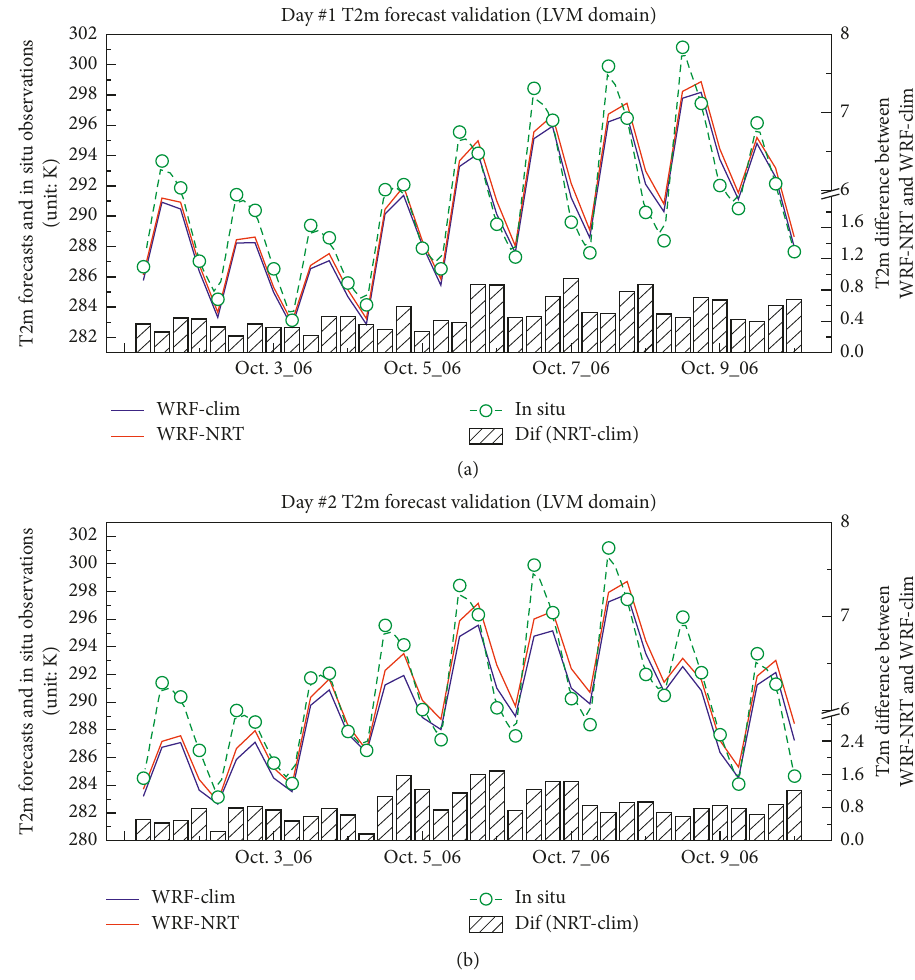
Figure 7: Forecasts of 2m surface air temperature from WRF runs (with climatology and NRT GVF) along with in situ observations for Day 1 forecasts (a) and Day 2 forecasts (b), averaged from validation sites over LMV